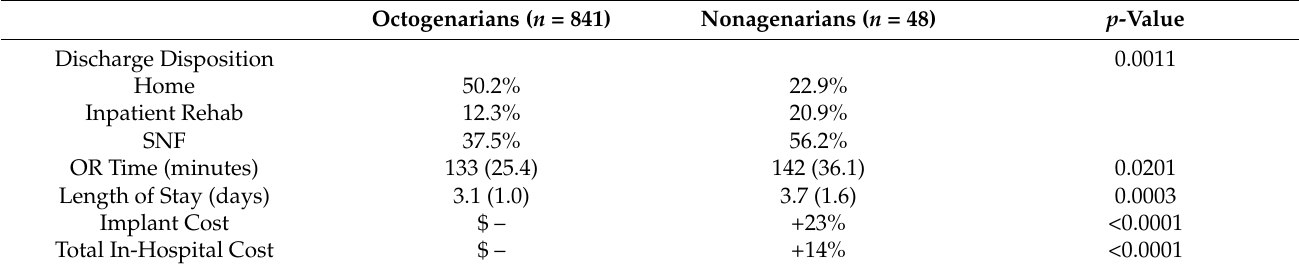
Table 4. Comparing outcomes and costs for total hip and knee arthroplasty between octogenarians and nonagenarians. SNF = skilled nursing facility. OR = operating room.